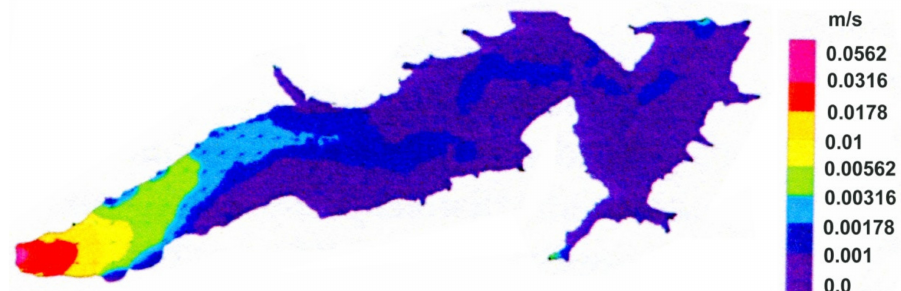
Figure 17. Two-dimensional field of the average vertical velocity in the main part of Lake Dobczyce (without the northern bay), with the total flow of 10 m 3 /s and no-wind conditions (model RMA2). Reprinted with permission from